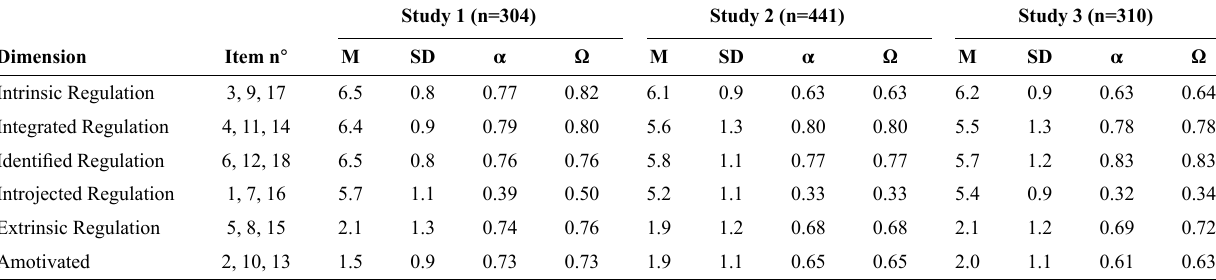
Table 2 - Internal consistency of the six dimensions of the SMS II questionnaire in the three studies. Study 1